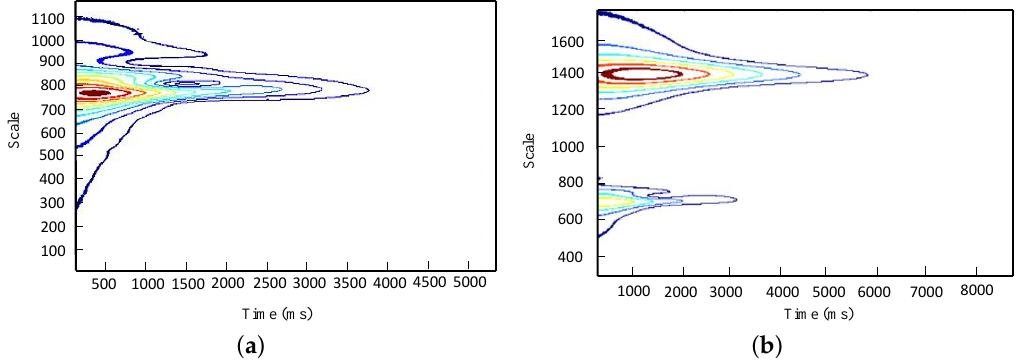
Figure 11. Wavelet coefficient contours. ( a ) Sensor #5; Scale:1,1000; ( b ) Sensor #1; Scale:1,1800.